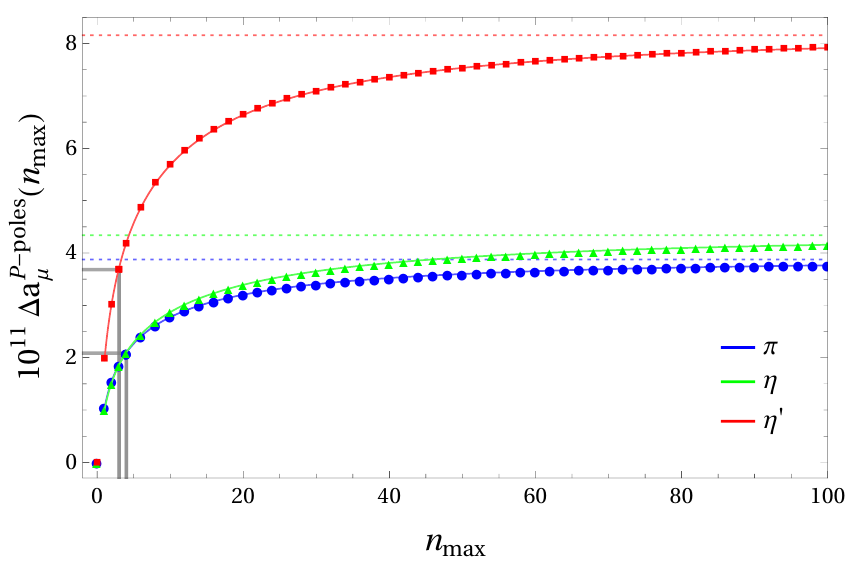
Figure 12. Sum over radially-excited pion, (cid:17) , and (cid:17) 0 contributions to ( g (cid:0) 2) (cid:22) , as de(cid:12)ned in (4.53). The dotted curves are the extrapolated values (cid:1) a P -poles corresponding to the limit n max ! 1 . The (cid:22) gray lines indicate the contributions from the lowest (observed) pseudoscalar excitations shown in (cid:12)gure 6. All results are calculated with the Model 2 TFFs